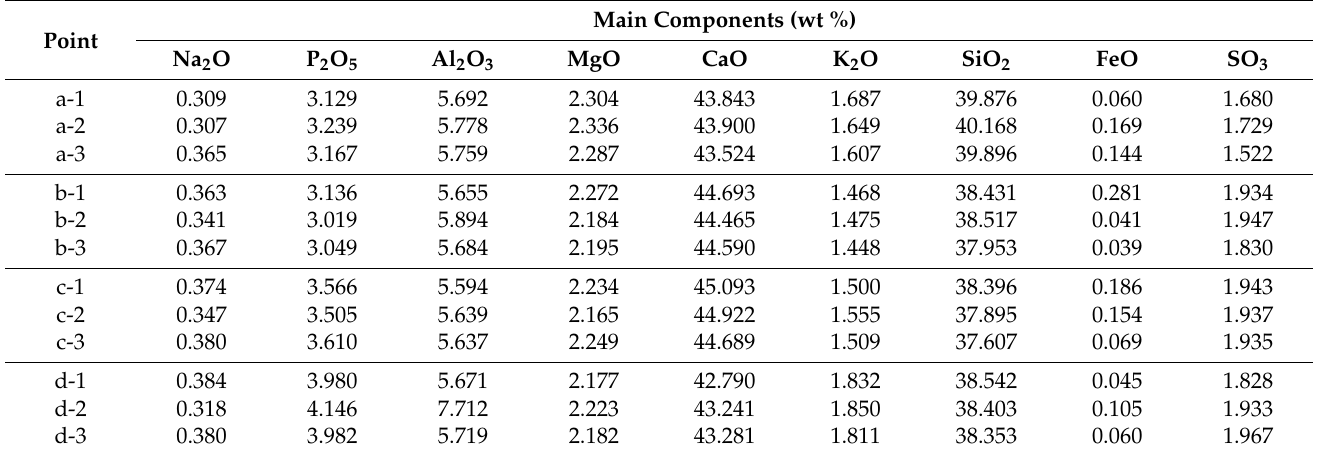
Figure 6. Backscattered electron image of phosphorous slag: ( a – d ) represents different positions of phosphorous slag respectively. Table 1. EMPA quantitative analysis results of marked dots in Figure